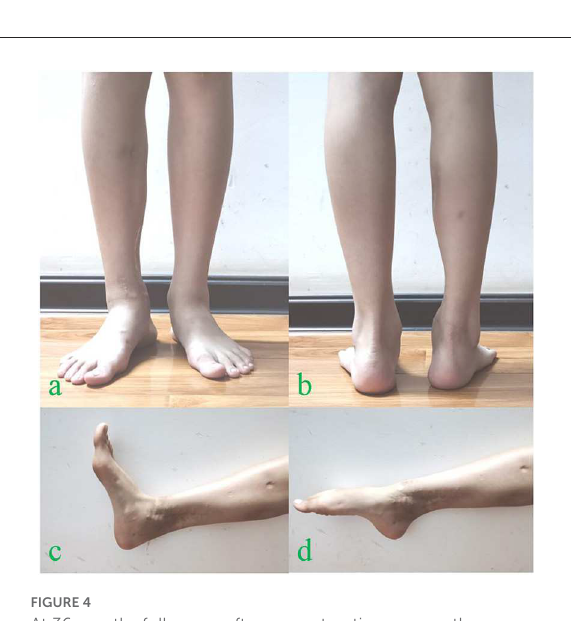
FIGURE4 At 36 months follow-up after reconstructive surgery, the apparent deformity was not evident (a,b) , the functional and cosmetic outcomes of the operated ankle (c,d)